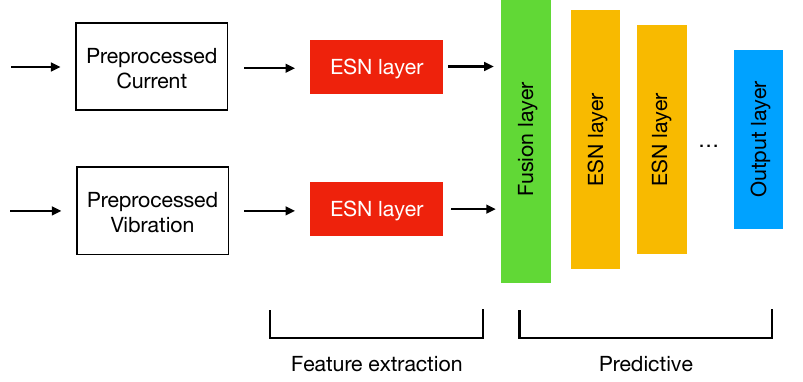
Figure 5. Proposed Sensor data fusion ESN